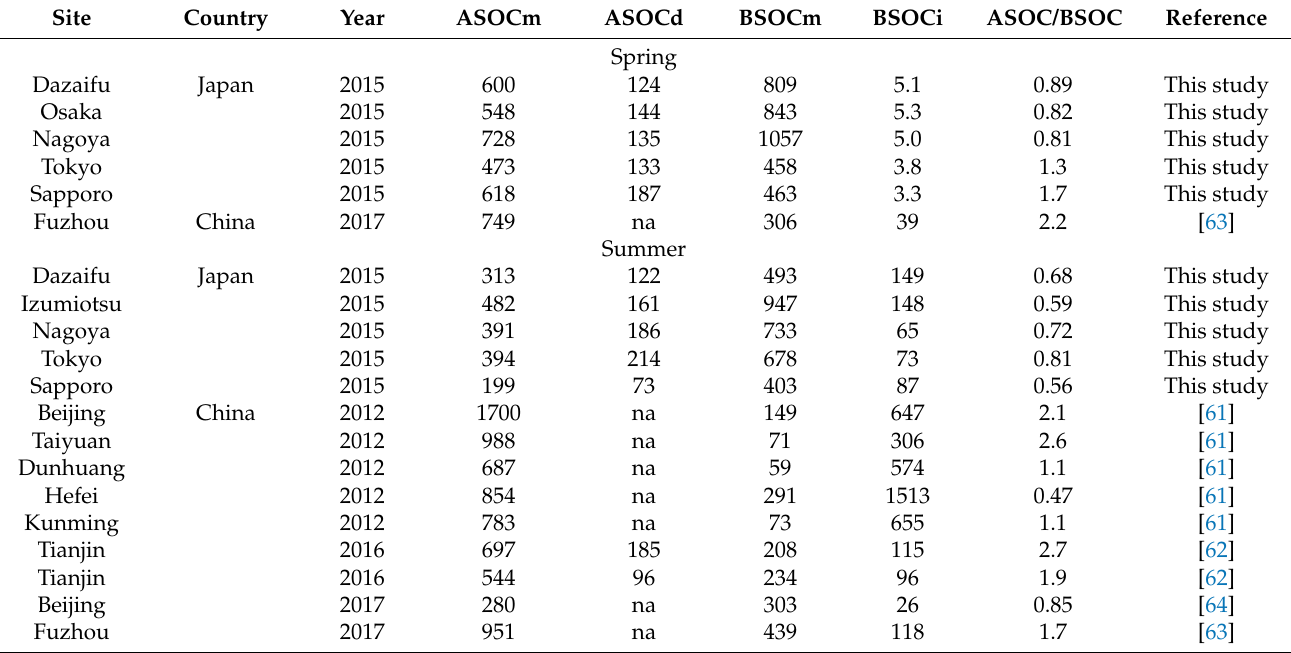
Table 6. Estimated SOC concentrations (ng/m 3 ) during spring and summer presented herein and those presented by [61–64] in